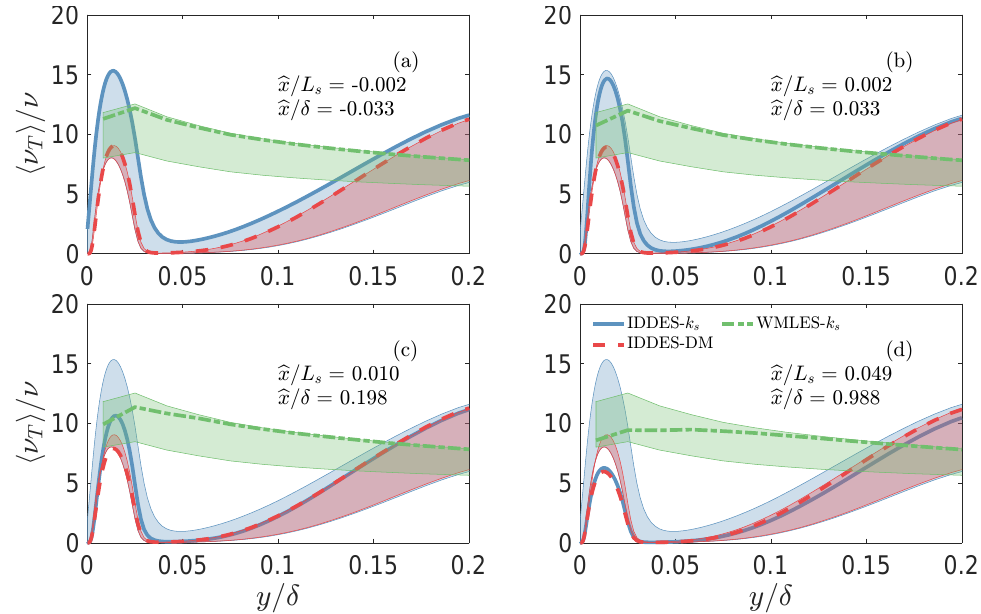
Figure 9. Profiles of the normalized eddy viscosity (cid:104) ν T (cid:105) / ν near the rough-to-smooth interface at ( a ) − 0.2%, ( b ) 0.2%, ( c ) 1% and ( d ) 5% of the smooth strip length. The shaded regions show the eddy viscosity variation between the fully smooth and fully rough limits (corresponding to the lower and upper boundaries,